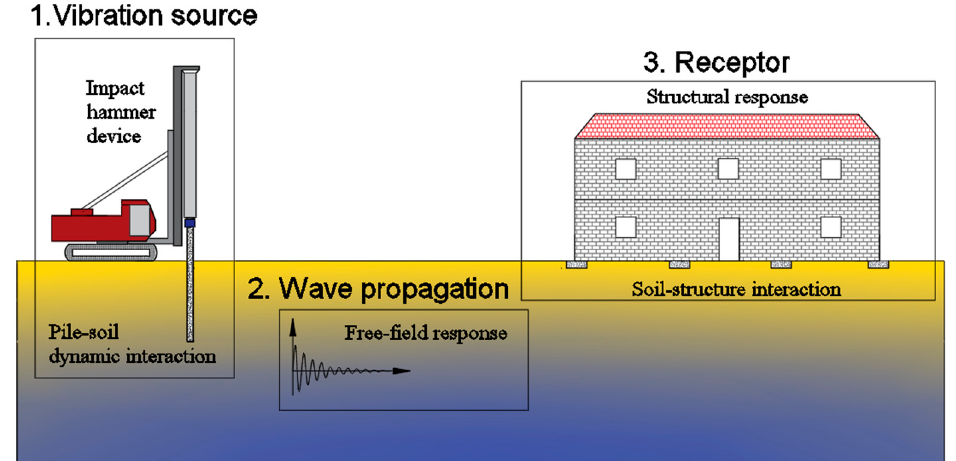
Figure 1. Representative scheme of the main physics of the problem.